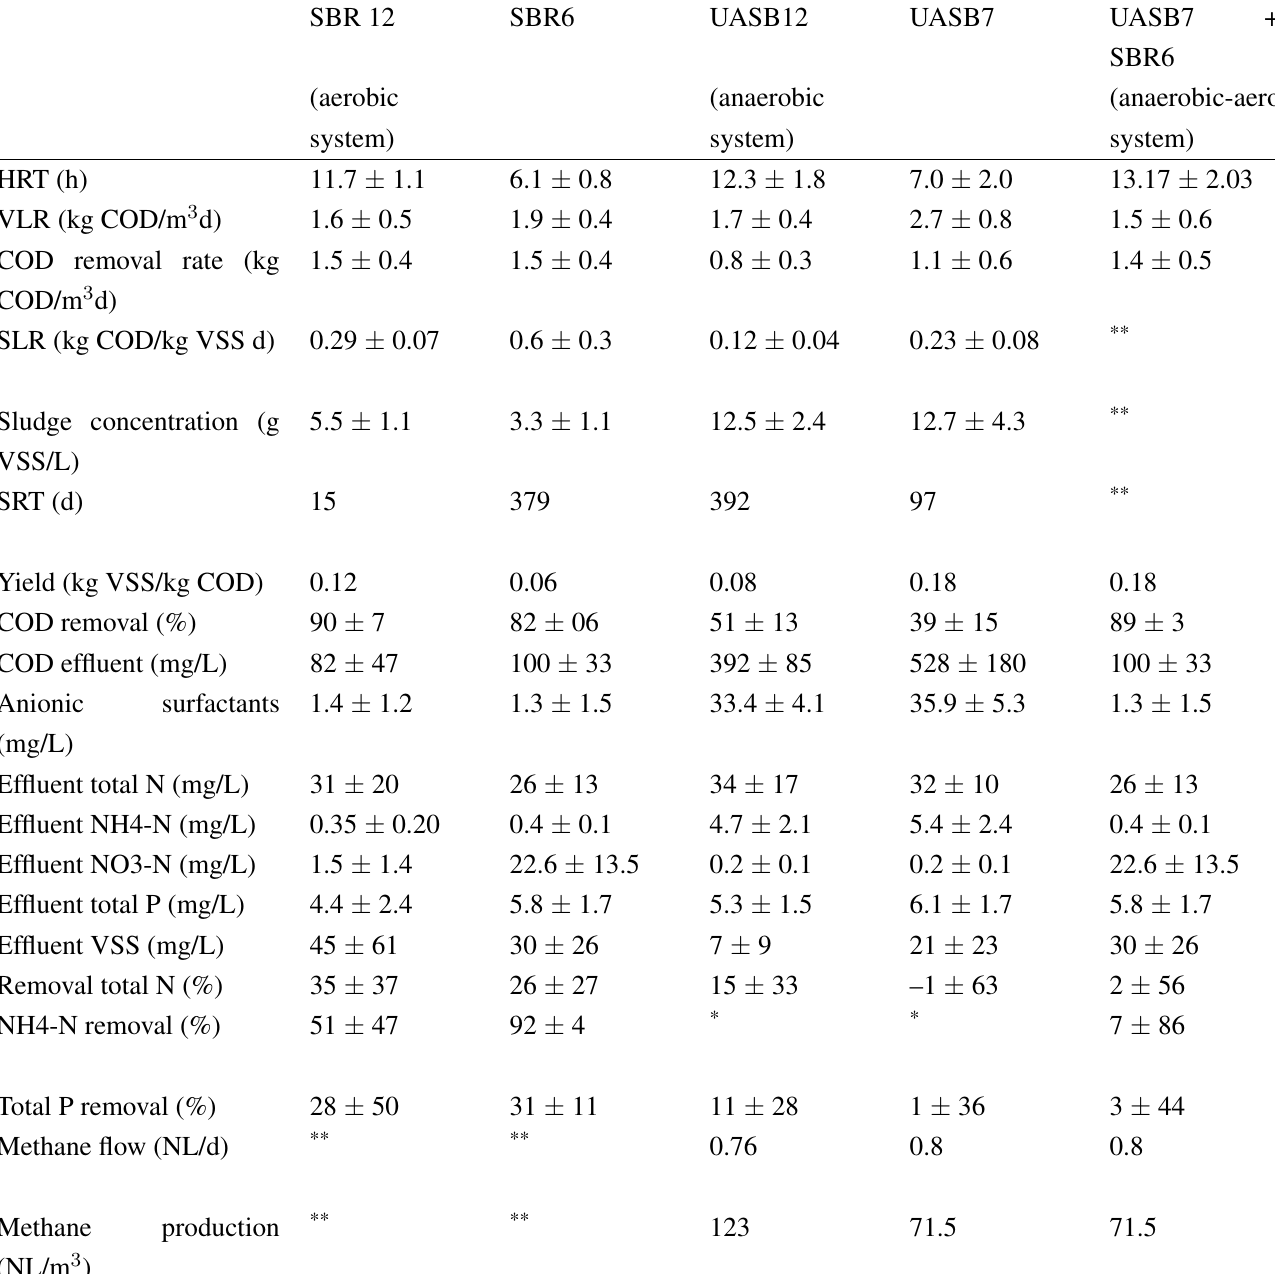
Table 3. Operation and performance of biological reactors for greywater